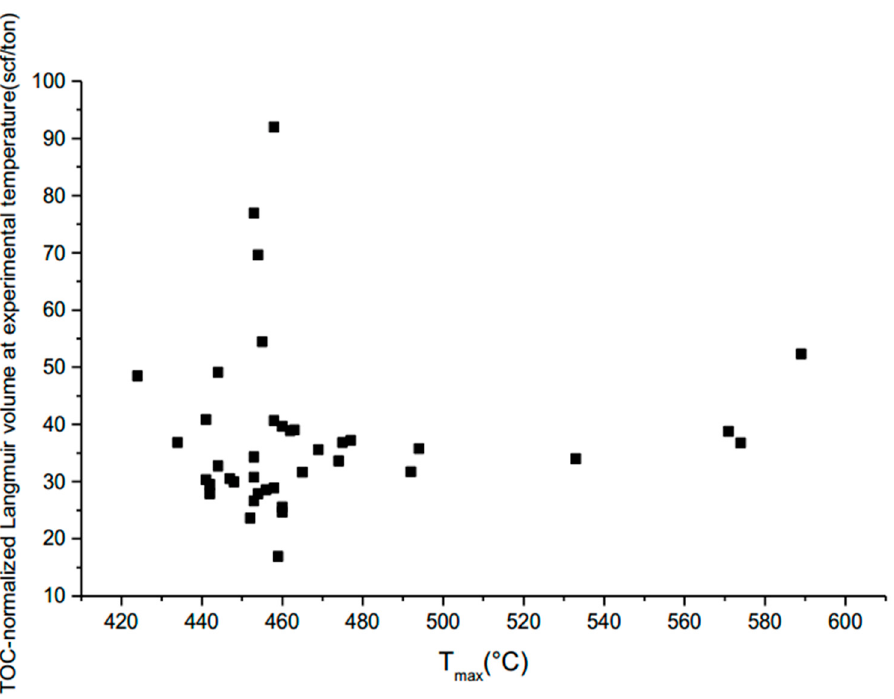
Figure 4. There is no meaningful relationship between the TOC-normalized Langmuir volume at experimental temperature and T max for the studied shale samples.